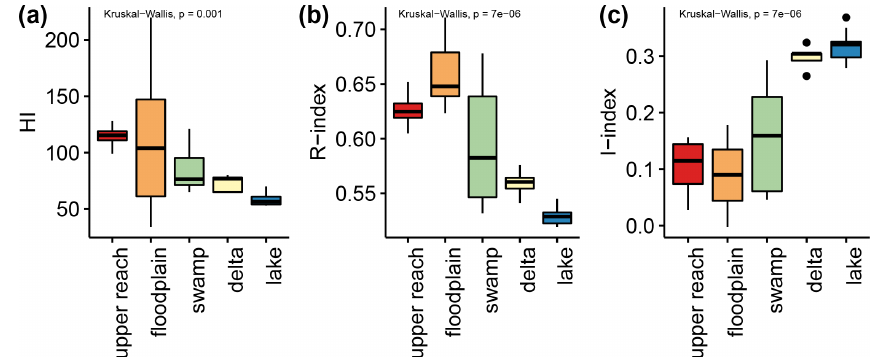
Figure 5. Displayed are the indices determined by Rock-Eval analyses. The hydrogen Index (HI, a ), R index ( b ), and I index ( c ), as introduced by Sebag et al. (2016), are displayed grouped by assigned sub-environments (see Fig. 1 and Sect. 3.1.1) of the Mkhuze Wetland System.